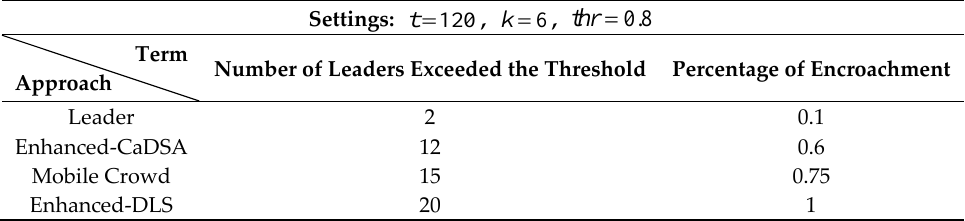
Table 1. Comparison of dangerous status of leaders.